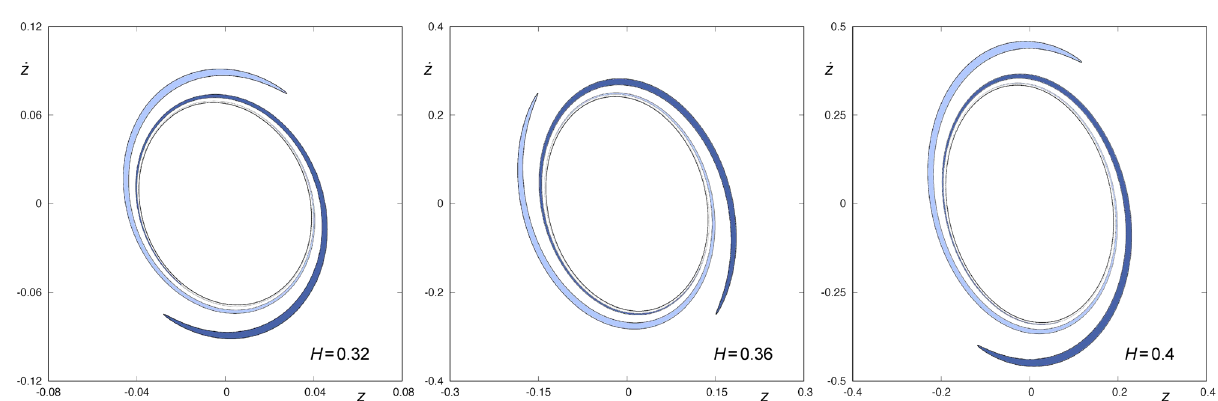
Figure 2. Intersection between W s ,2 (φ) and W u ,1 (φ) for H = 0.32, 0.36 and 0.44 (from left to right, respectively). Orbits starting in the area enclosed by W u ,1 (φ) , colored in light or dark grey, come from the infinity. Orbits with initial conditions belonging to the area enclosed by W s ,2 (φ) and W u ,1 (φ) , colored in a dark grey tone, come from the infinity and leave the galaxy after intersecting the hyperplane r = ¯ r two times. Orbits starting in the area delimited by one of the pair of tongues colored in blue can be integrated backward until they intersect again the hyperplane r = ¯ r , and leave the galaxy in the future by the opening of the curves of zero velocity. This graphic has been generated by using Gnuplot Version 5.2. http:// www. gnupl ot. info.